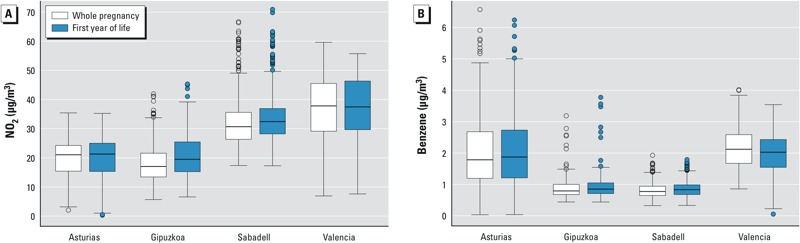
Distribution of exposures to outdoor NO2 (A) and benzene (B) during pregnancy and first year of life by study area. Boxes extend from the 25th to the 75th percentile, horizontal bars represent the median, whiskers extend 1.5 times the length of the IQR above and below the 75th and 25th percentiles, respectively, and outliers are represented as points.